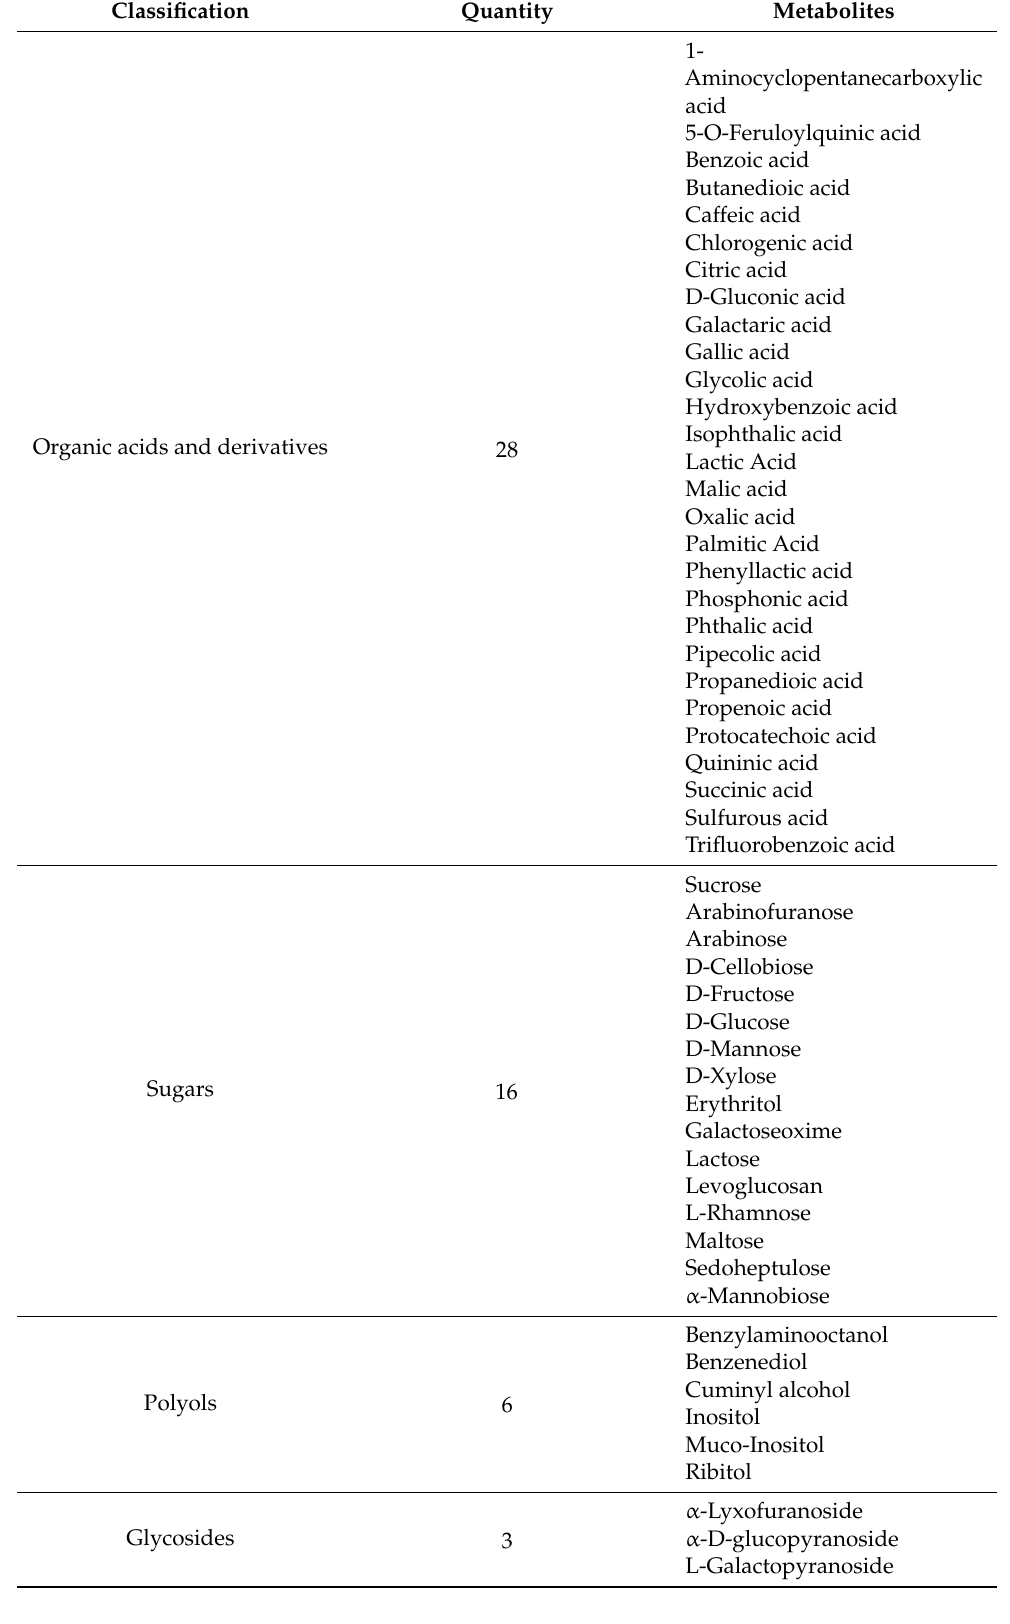
Table 1. Classification of 84 metabolites based on Bupleurum